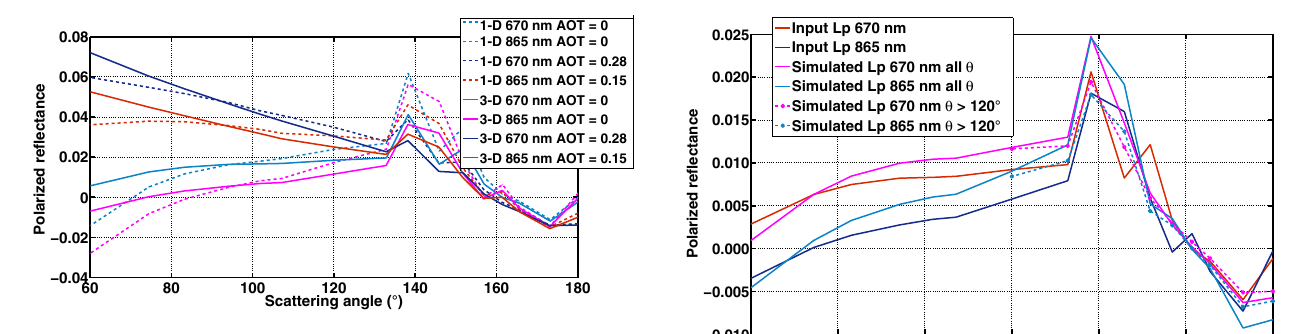
Figure 6. Polarized reflectances as a function of the scattering an- gle. Dashed lines are for homogeneous cloud with and without a biomass burning aerosol layer above; solid lines are for the frac- tional cloud with and without a biomass burning aerosol layer above. The solar zenith angle is 60 ◦ .